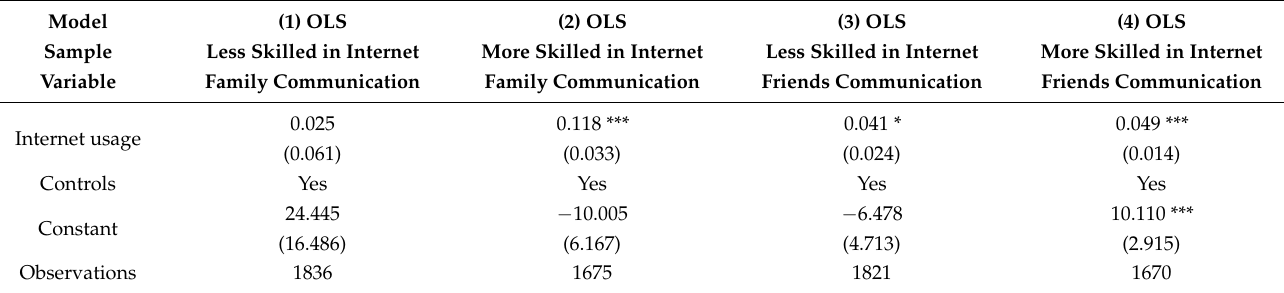
Table 11. Heterogeneity analysis, in terms of Internet skills.